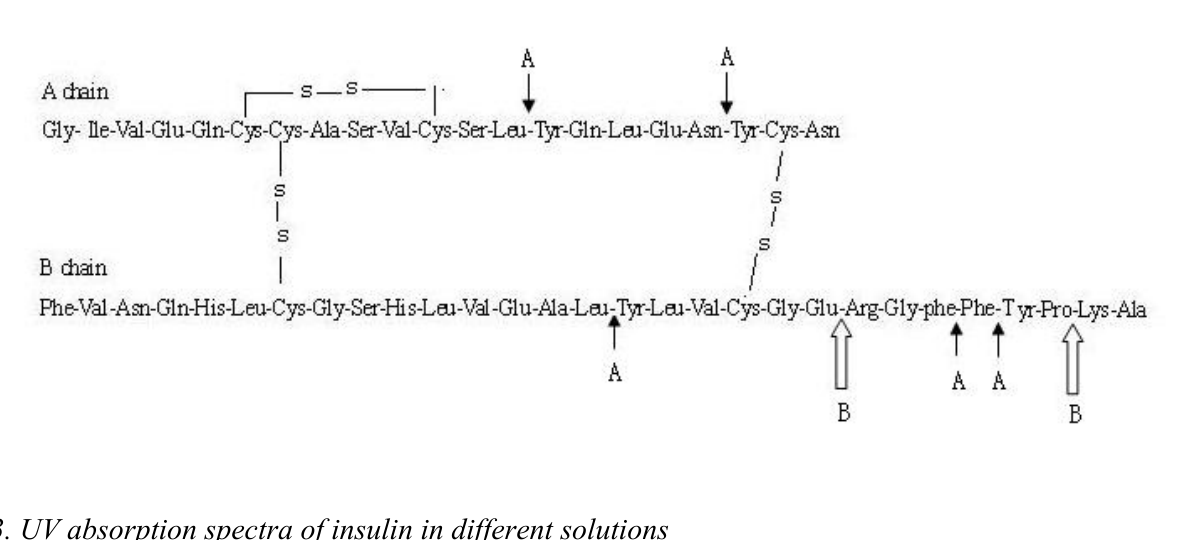
Figure 5. The cleavage site of insulin by proteases. A: The sites are the recognized site of α - chymotrypsin; B : The sites are the recognized sites of